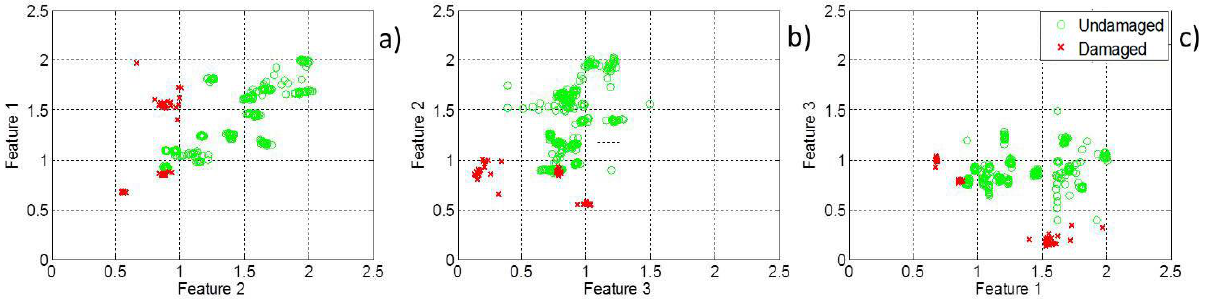
Figure 3. Feature maps for all the possible two-by-two combinations of the three features, plotted as two-dimensional